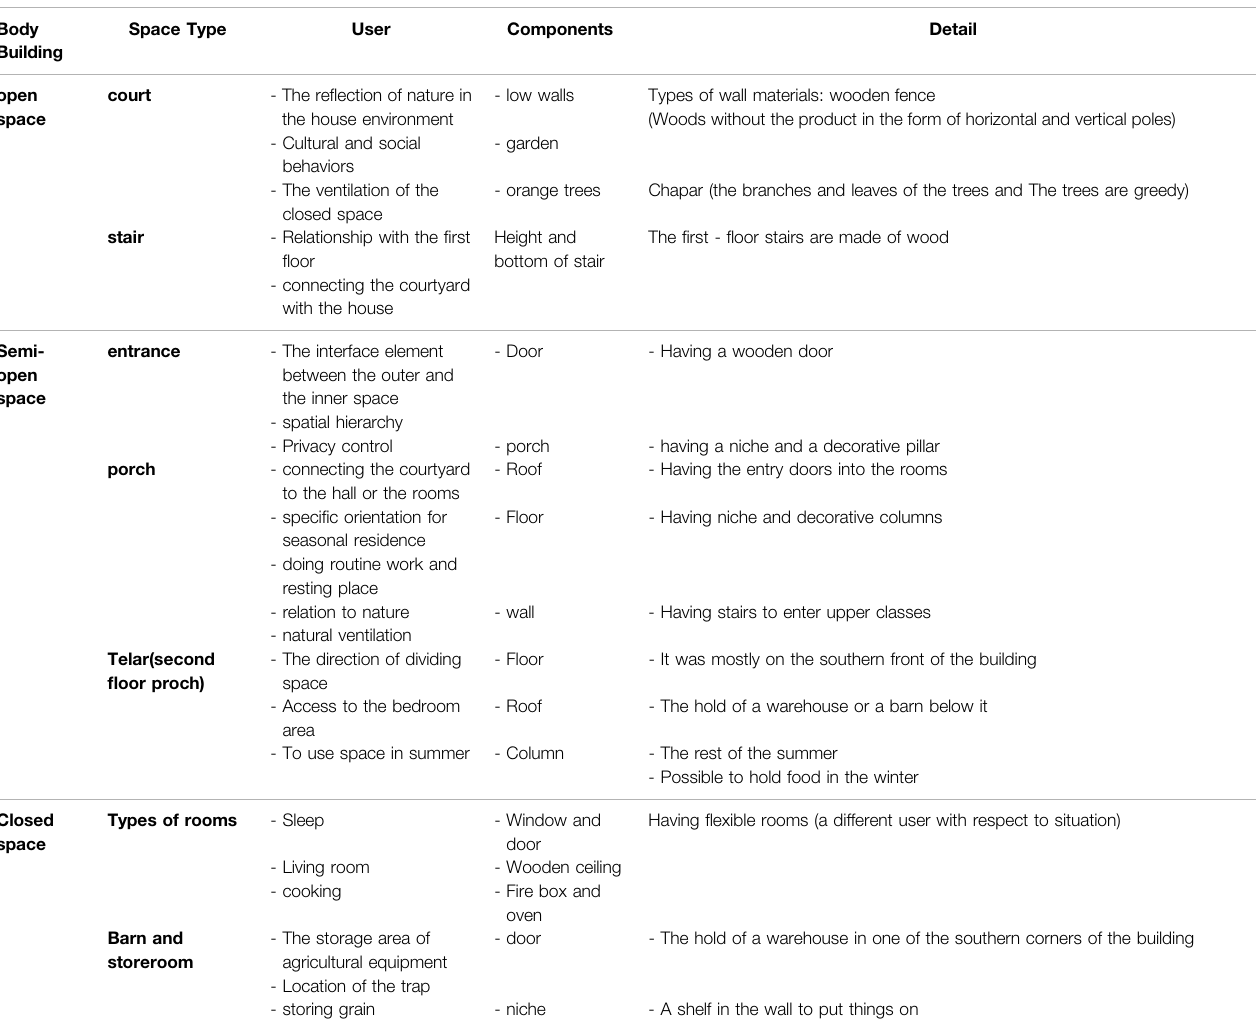
TABLE 3 | The building spaces in the village of Talesh, Source: author. Body